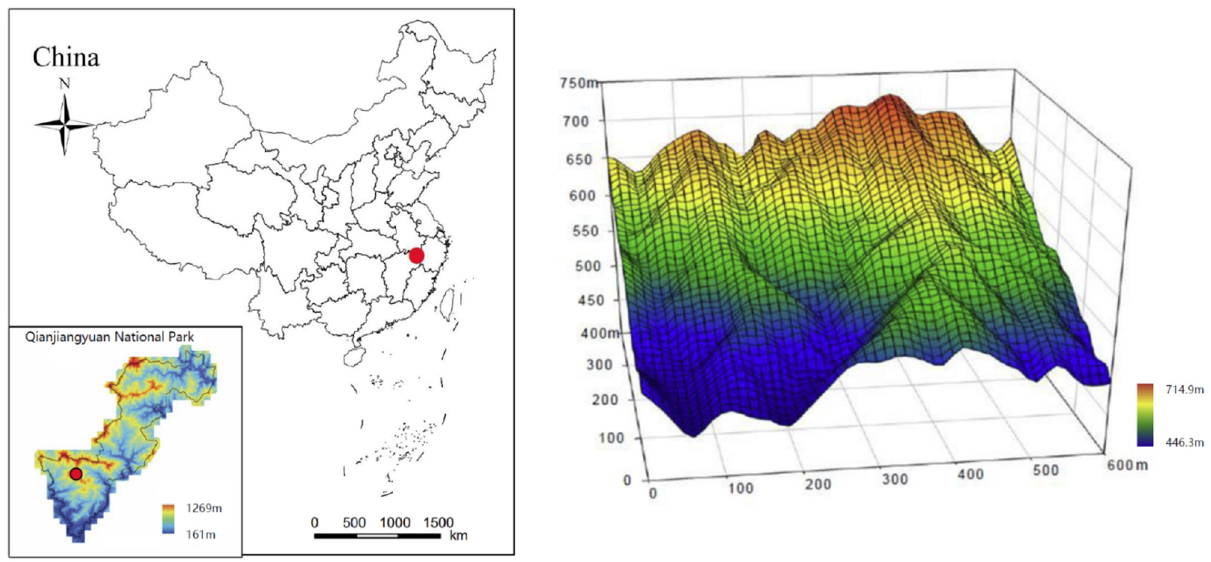
Figure 1. Location map of the 24-ha Gutianshan forest plot in Qianjiangyuan National Park in China. The red point signifies the study site. The axis in the 3D plot represents the height difference of the 24-ha plot.